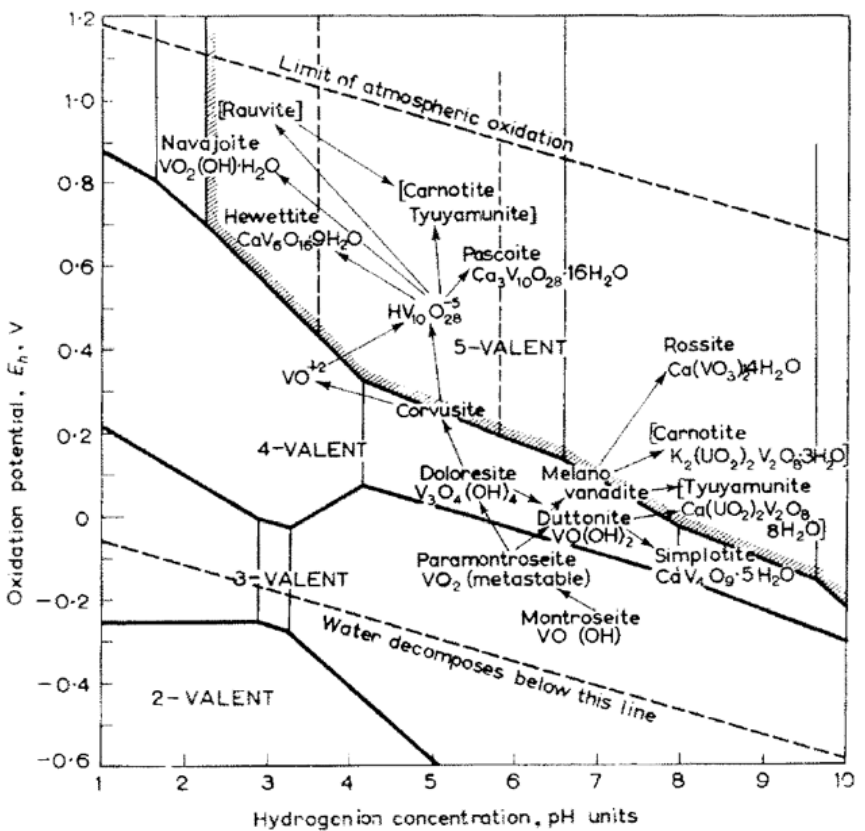
Figure 2. Pourbaix diagram showing oxidation potential (E h ) vs. pH. Adapted with permission from Ref. [39]. © 1959 by Elsevier.